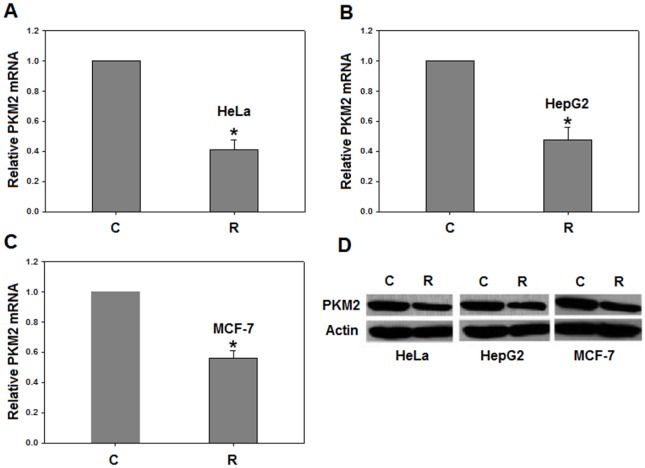
Resveratrol decreases PKM2 expression.Resveratrol treatment decreases PKM2 mRNA in (A), HeLa; (B), HepG2 and (C), MCF-7; by approximately two-folds. β-actin was taken as endogenous control and normalized to PKM2 mRNA. Relative quantification analysis was done using SDS 1.1 RQ software. Western blot showing decreased PKM2 protein in all the cell lines studied on treatment with 50 µM resveratrol (D). C- Mock treated control and R- resveratrol treated. All experiments were repeated 3 times and data is expressed as mean ± SE. *p<0.05.